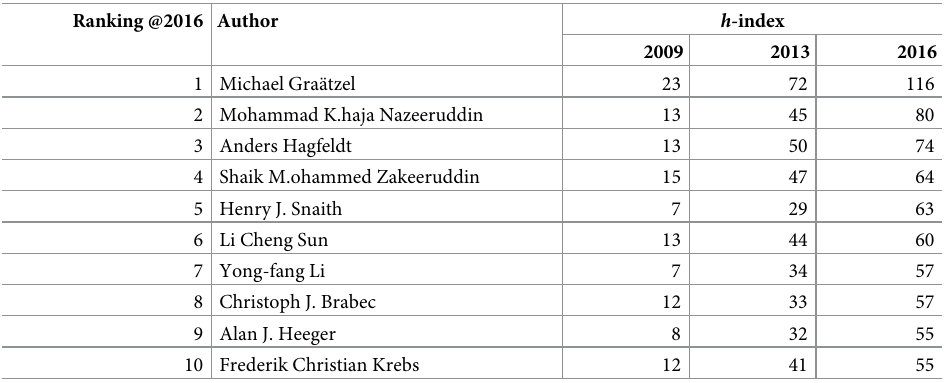
Table 4. h -index ranking in the